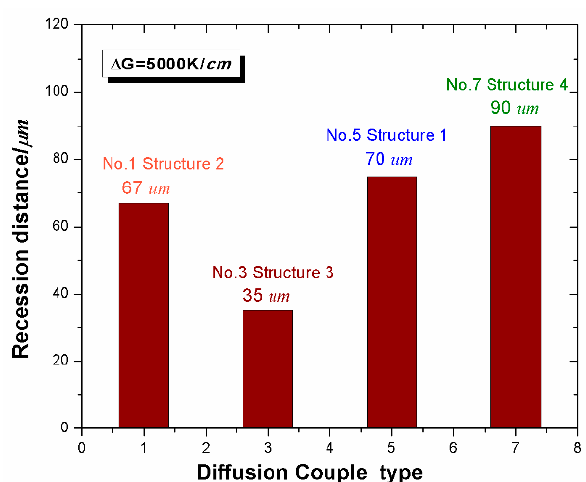
Figure 12. Recession distances of γ ' phase in different diffusion couple systems after interdiffusion for 485,000 s with the effect of temperature gradient.